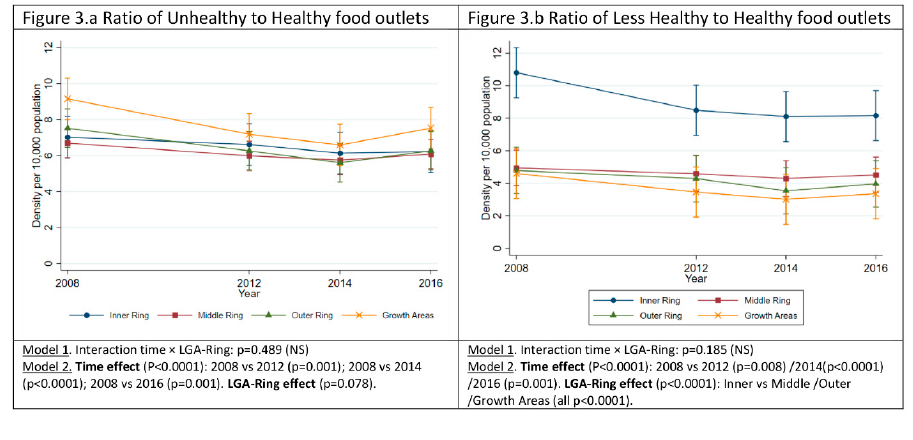
Figure 3. Ratio of Unhealthy and Less Healthy to Healthy food outlets over the period 2008–2016 and across local government areas grouped by distance from Greater Melbourne Central Business District (LGA-Ring).